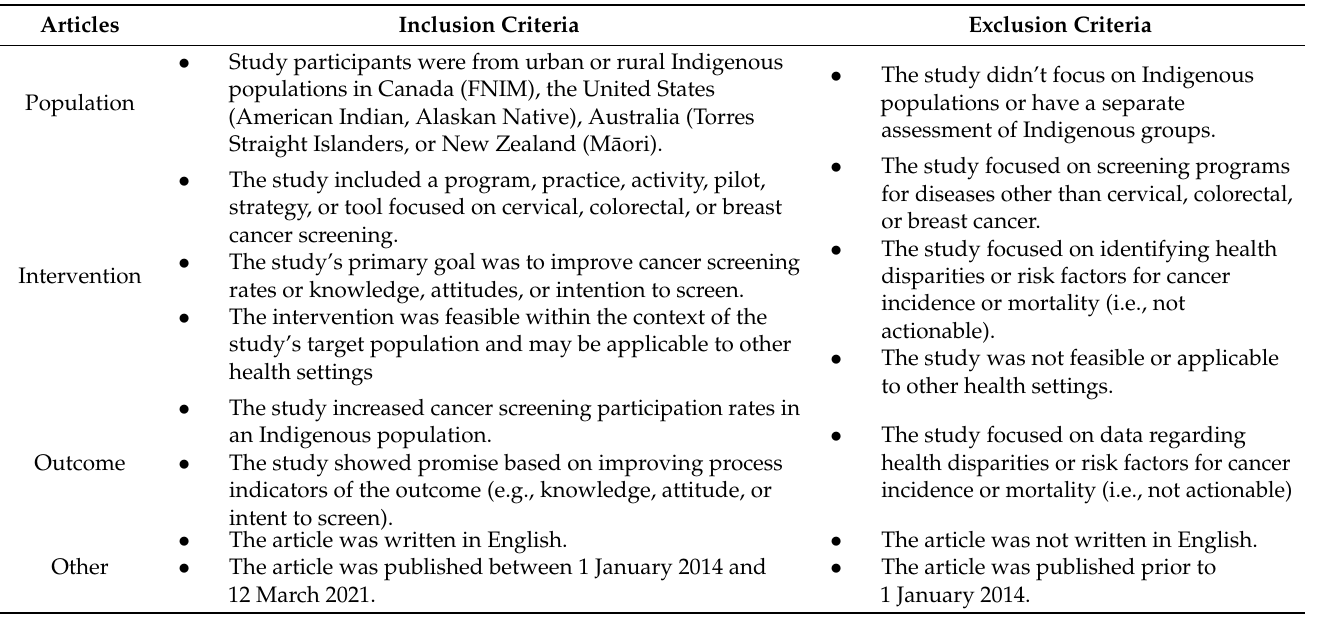
Table 2. Inclusion and exclusion criteria for the selection of